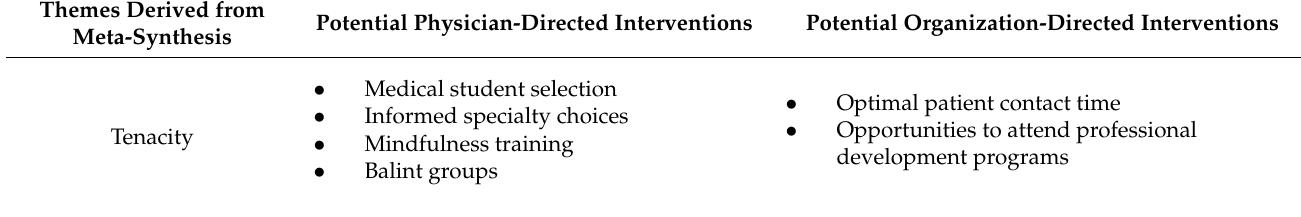
Table 5. Potential physician- and organization-directed interventions to address different themes of resilience